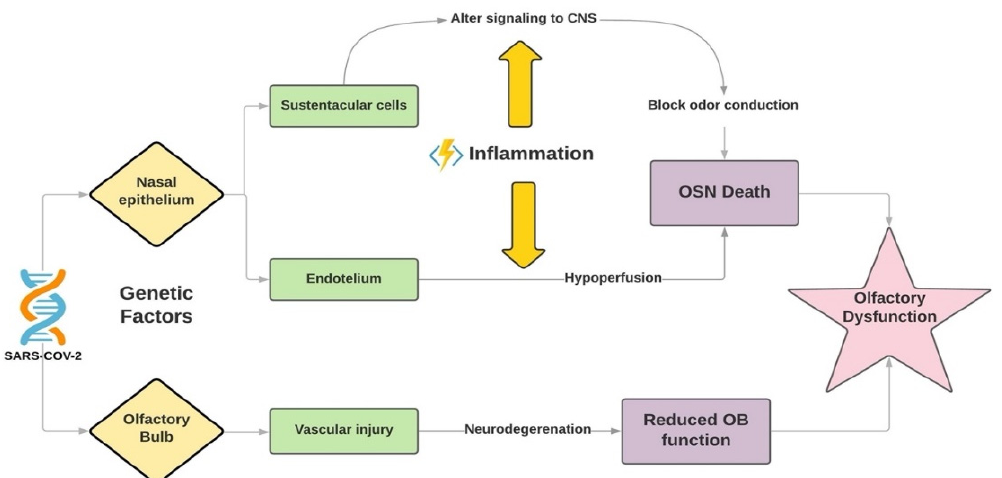
Figure 1. Pathogenesis of olfactory dysfunction. Infection of mesenchymal stromal and vascular cells in the nose and bulb and their subsequent inflammation affect the neuronal conduction, reduce nutritional and water supplies and, therefore, cause the death of olfactory sensory neurons (OSNs) and damage to olfactory bulb function. SARS-COV-2 indicates severe acute respiratory syndrome coronavirus 2; CNS, central nervous system; OB, olfactory bulb; OSN, olfactory sensory neurons .